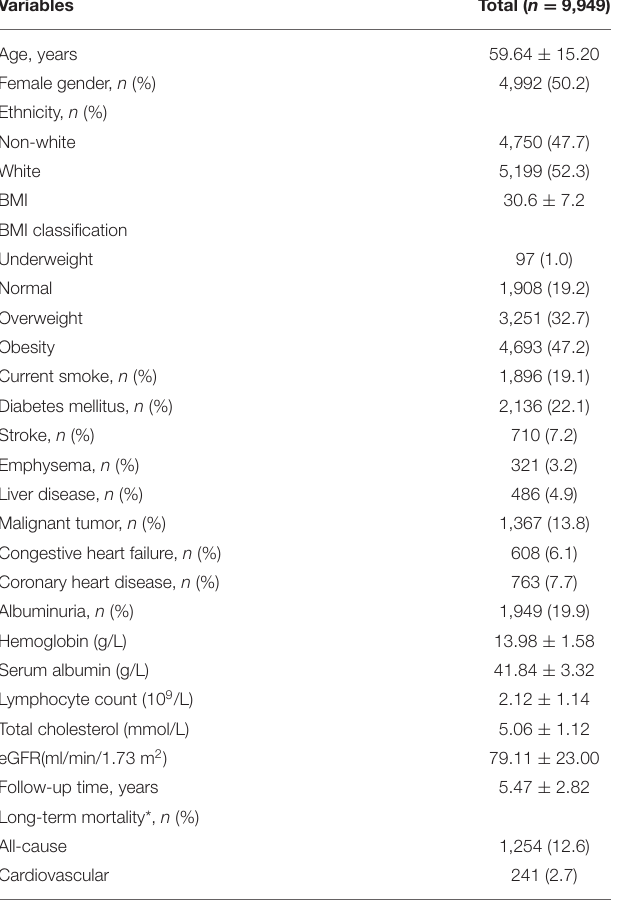
TABLE 1 | Baseline clinical characteristics of included patients. TABLE 2 | Prevalence of malnutrition according to three nutritional screening